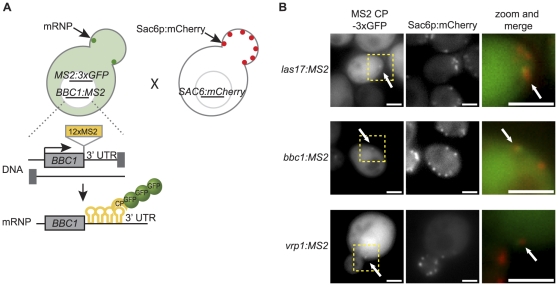
Actin patch nucleator mRNAs are localized to actin patches.(A) Schematic of fluorescent strain construction for visualization of mRNA particles and actin patches in live cells. The sequence for 12 MS2 hairpins was integrated between the coding region of the gene of interest (e.g. BBC1) and the 3′ UTR at the native genomic locus. Cells with the gene:MS2 construct also harbored a plasmid allowing inducible expression of the MS2 hairpin-binding coat protein (CP) fused to three tandem copies of enhanced green fluorescent protein (3xGFP), allowing visualization of discrete mRNA particles in live cells. Haploid strains harboring the MS2 constructs were mated to haploid strains harboring an integrated mCherry C-terminal fusion of the S. cerevisiae fimbrin protein, Sac6p. (B) Visualization of MS2-CP-3xGFP tagged mRNAs (left panel) and Sac6p:mCherry (middle panel) in diploid cells. Areas of interest in the left panel, highlighted by the yellow bounding box, are shown in the right panel. mRNAs of interest are highlighted by a white arrow. Scale bars are 2 µm.